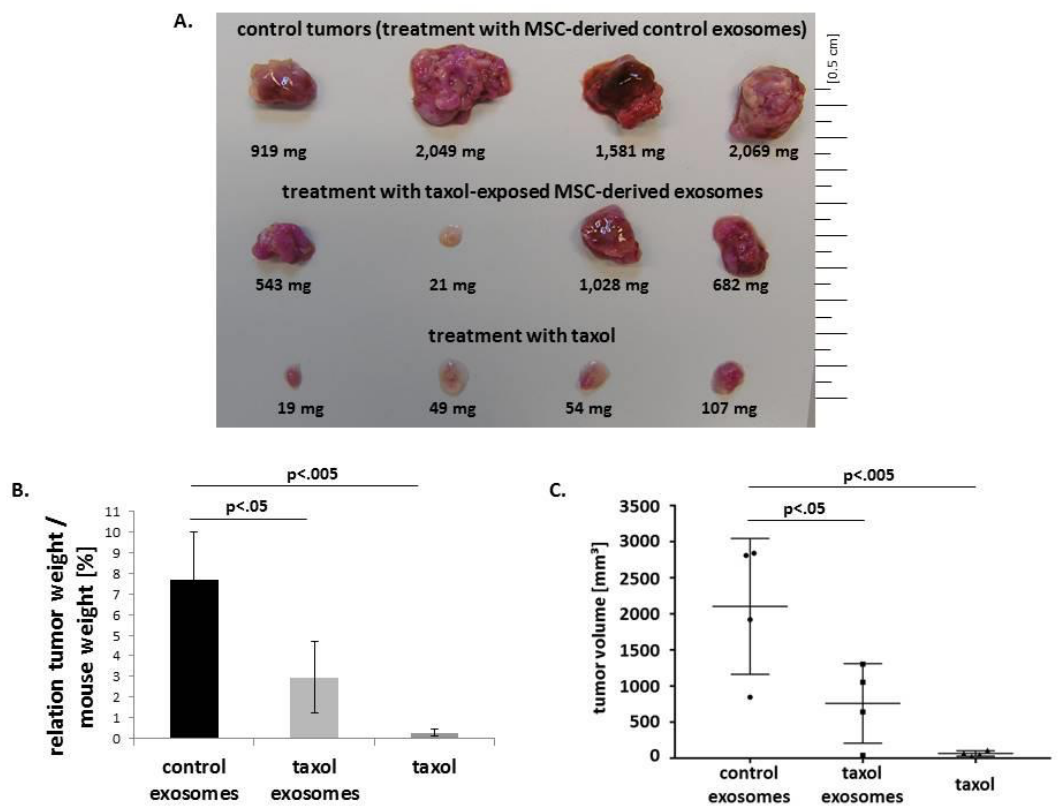
Figure 6. Tumors were grown in NODscid mice after injection of human mcherry-labeled MDA-hyb1 breast cancer cells. ( A ) Tumor weight of each treatment group ( n = 4) was measured after dissection of the solid subcutaneous primary tumors only (excluding metastatic tumor tissue). ( B ) The mouse weight was determined and the ratio of tumor weight to the corresponding mouse weight was calculated. Data represent the mean ± s.d. and significance ( p ) was calculated by ANOVA followed by Dunnett´s multiple comparisons test. ( C ) Tumor length and width of each tumor was measured and the average tumor volume was calculated for each treatment group according to [41]. Data represent the mean ± s.d. and significance ( p ) was calculated by ANOVA followed by Dunnett´s multiple comparisons test.